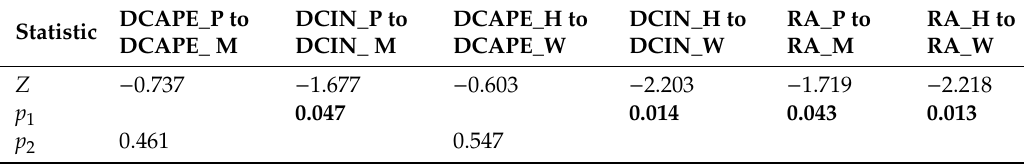
Figure 1. Box-and-whisker plots of thermodynamic variables (DCAPE, and DCIN; J kg − 1 ) of elevated thunderstorms for the Prolific ( ≥ 5 severe reports) case set on the left, ending in “_PRO”, compared to the Marginal ( < 5 severe reports) case set on the right, ending in “_MAR”. Top (bottom) of each box represents the 75th (25th) percentile, with whiskers at 95% and 5%. Outliers are plotted as dots. Dashed (solid) lines within the box represent the mean (median). Table 1. Mann-Whitney U test results on thermodynamic variables DCAPE, DCIN, and the ratio | DCIN |/| DCAPE | (RA) for the Prolific case set (ending in “_P”) to the Marginal case set (ending in “_M”), and the Hail-Dominant case set (ending in _H”) to the Wind-Dominant case set (ending in